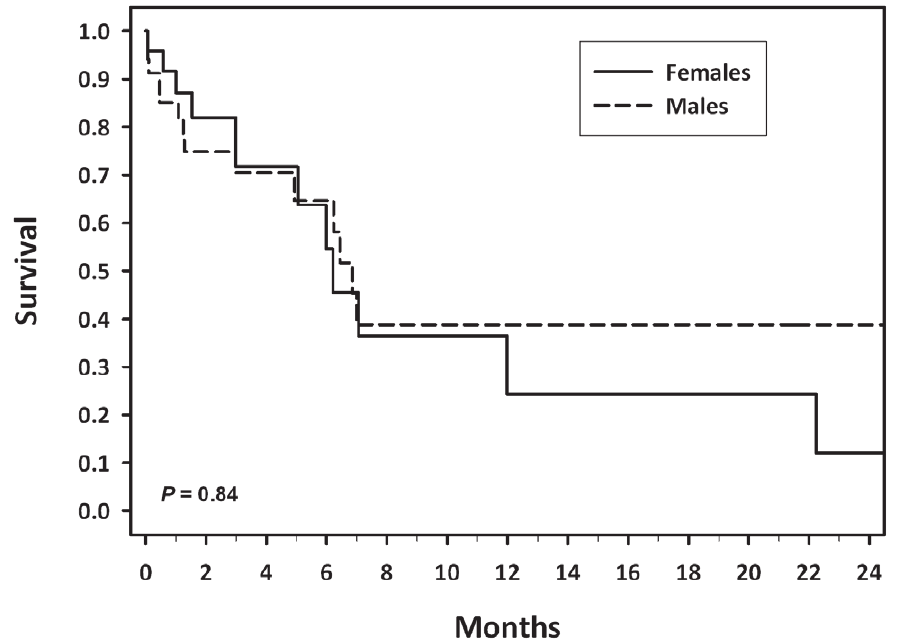
Figure 2. Survival with esophageal cancer in young patients by sex. Survival by sex of the 60 esophageal cancer patients # 30 years of age seen at Tenwek Hospital from January 1996 through June 2009 who had follow-up information.